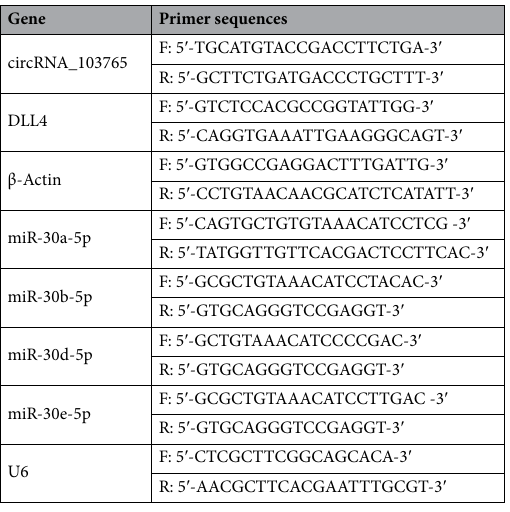
Table 4. Sequences of primers used in this study. DLL4 delta-like ligand